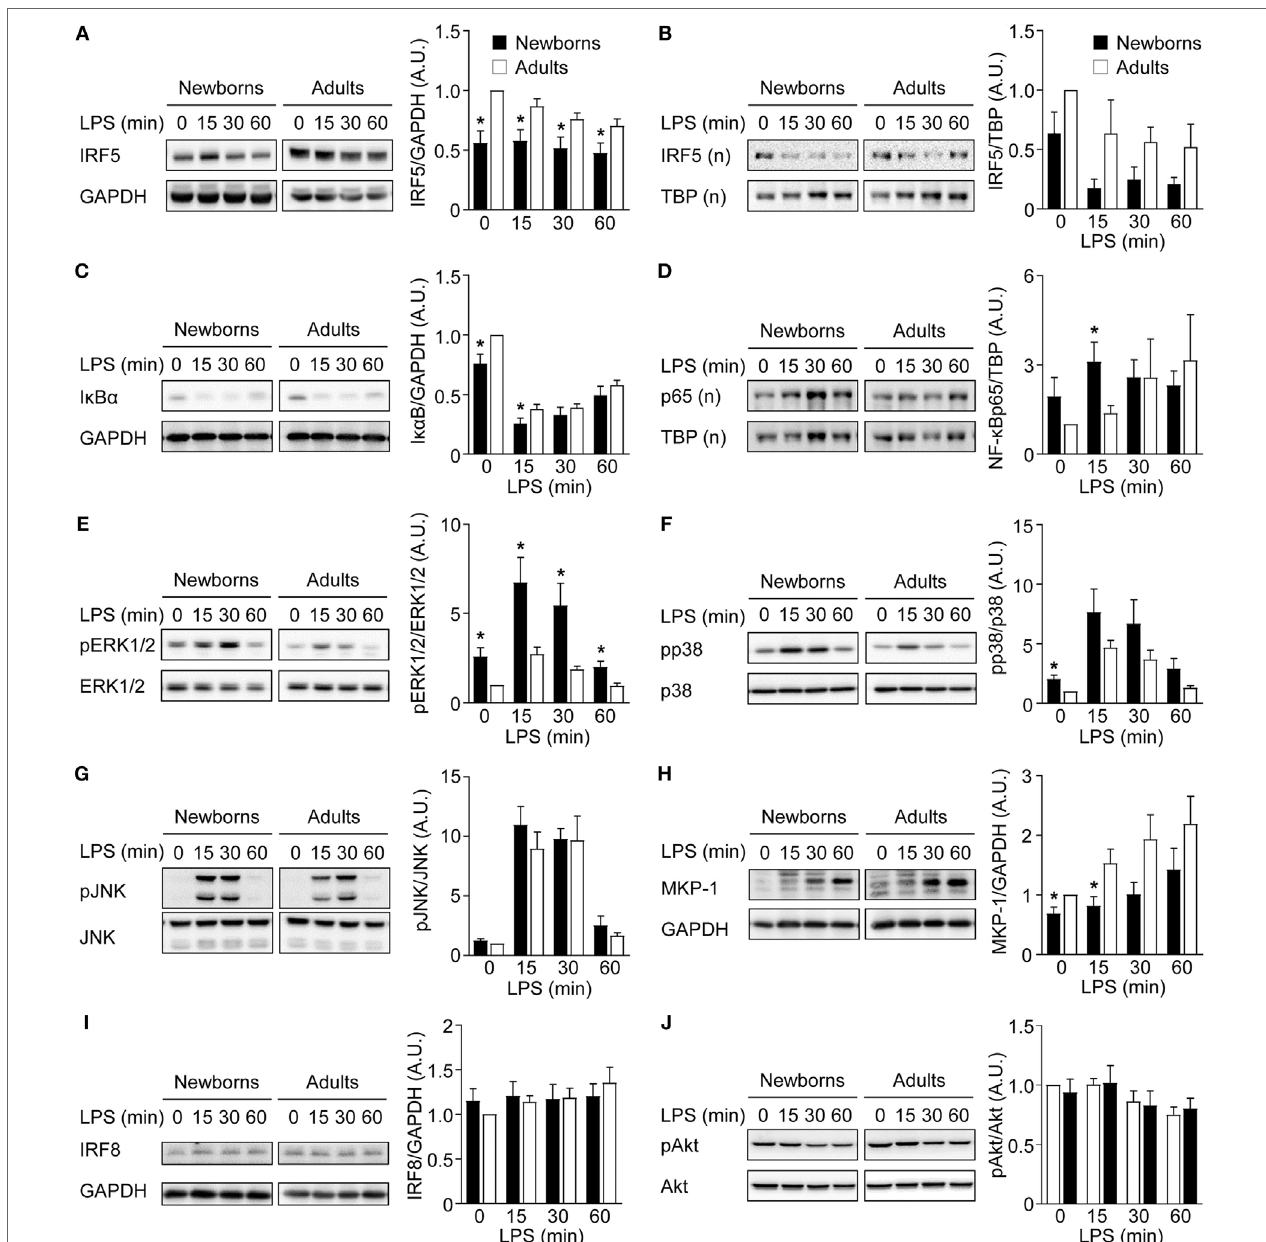
FigUre 5 | Reduced IRF5 expression levels in newborn M1 macrophages. Newborn (black bars) and adult (white bars) M1 macrophages were stimulated with 100 ng/ml lipopolysaccharide for 0–60 min. IRF5 (a,B) , I κ B α (c) , NF- κ Bp65 (D) , phosphorylated and total ERK1/2 (e) , p38 (F) and JNK (g) , MAP kinase phosphatase-1 (h) , IRF8 (i) , and phosphorylated and total Akt (J) were analyzed by Western blotting using total (a,c,e–J) or nuclear (B,D) cellular extracts and quantified by imaging. Values were normalized to those obtained from resting adult M1 macrophages set at 1. Data are means ± SEM from 8 to 10 newborns and 8 to 10 adults. * P <